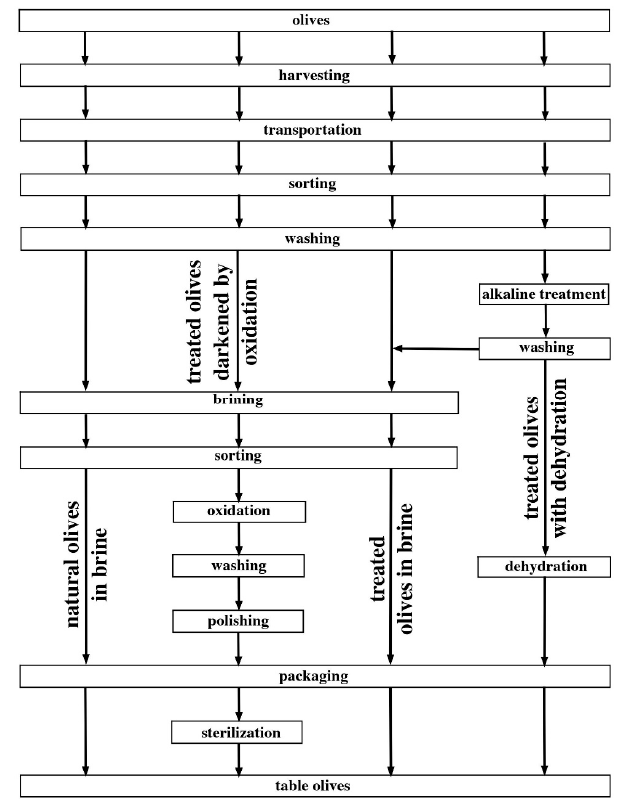
Figure 1. Main steps of widespread processing methods for table olives.